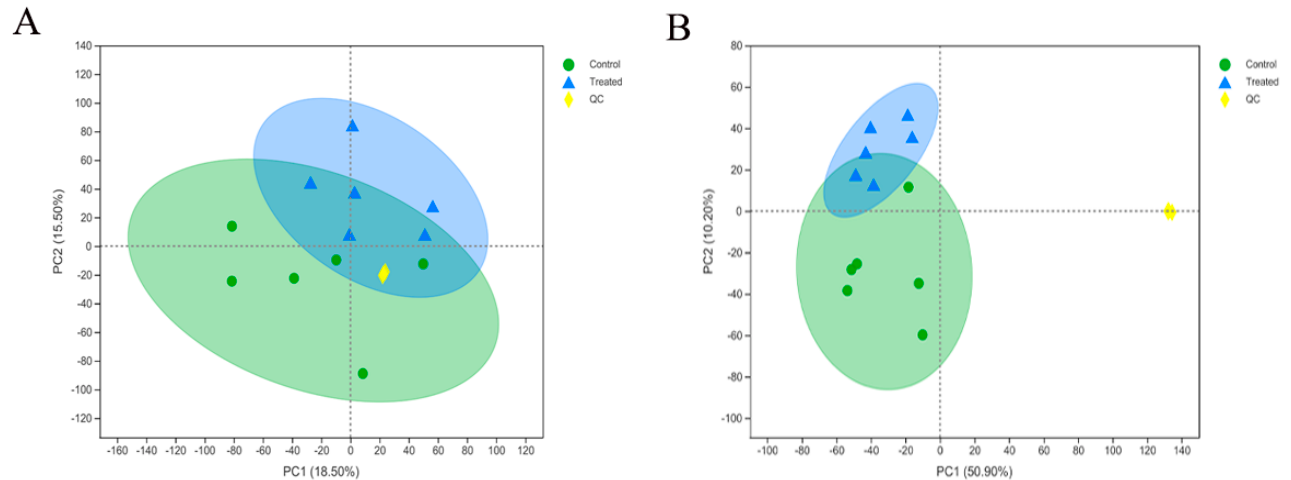
Figure 3. Principal component analysis (PCA) score plot of control; treated and QC samples under positive ion mode (POS) ( A ) and negative ion mode (NEG) ( B ). PCA based on the UHPLC-MS/MS spectra of quality control (QC) samples and metabolites in dermal papilla cells obtained from the control group and treated group (copper group) ( n = 6).